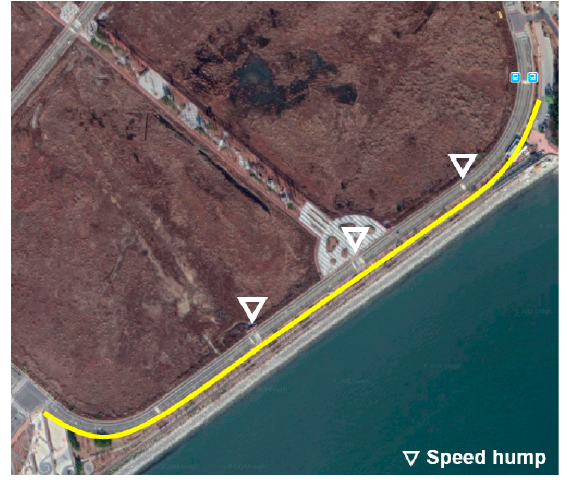
Figure 8. Test route for speed bump situations.